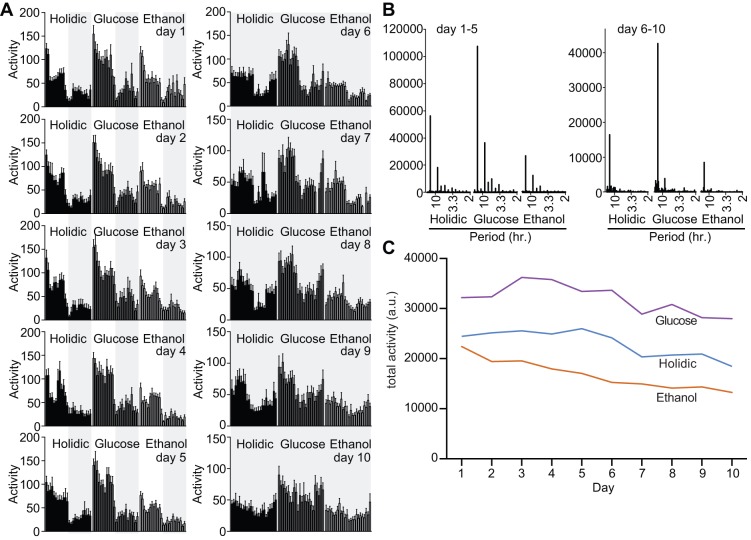
Glucose increases adult Drosophila activity. (A) Actograms showing average hourly activity of flies fed an unmodified diet (holidic), or a holidic diet supplemented with glucose or ethanol as indicated. Results are the mean of 20 individual measurements, and error bars indicate standard errors. Shaded areas indicate periods of darkness. (B) Periodograms of days 1-5 and 6-10 for flies raised on the respective diets. (C) Total daily activity of flies raised on the respective diets.